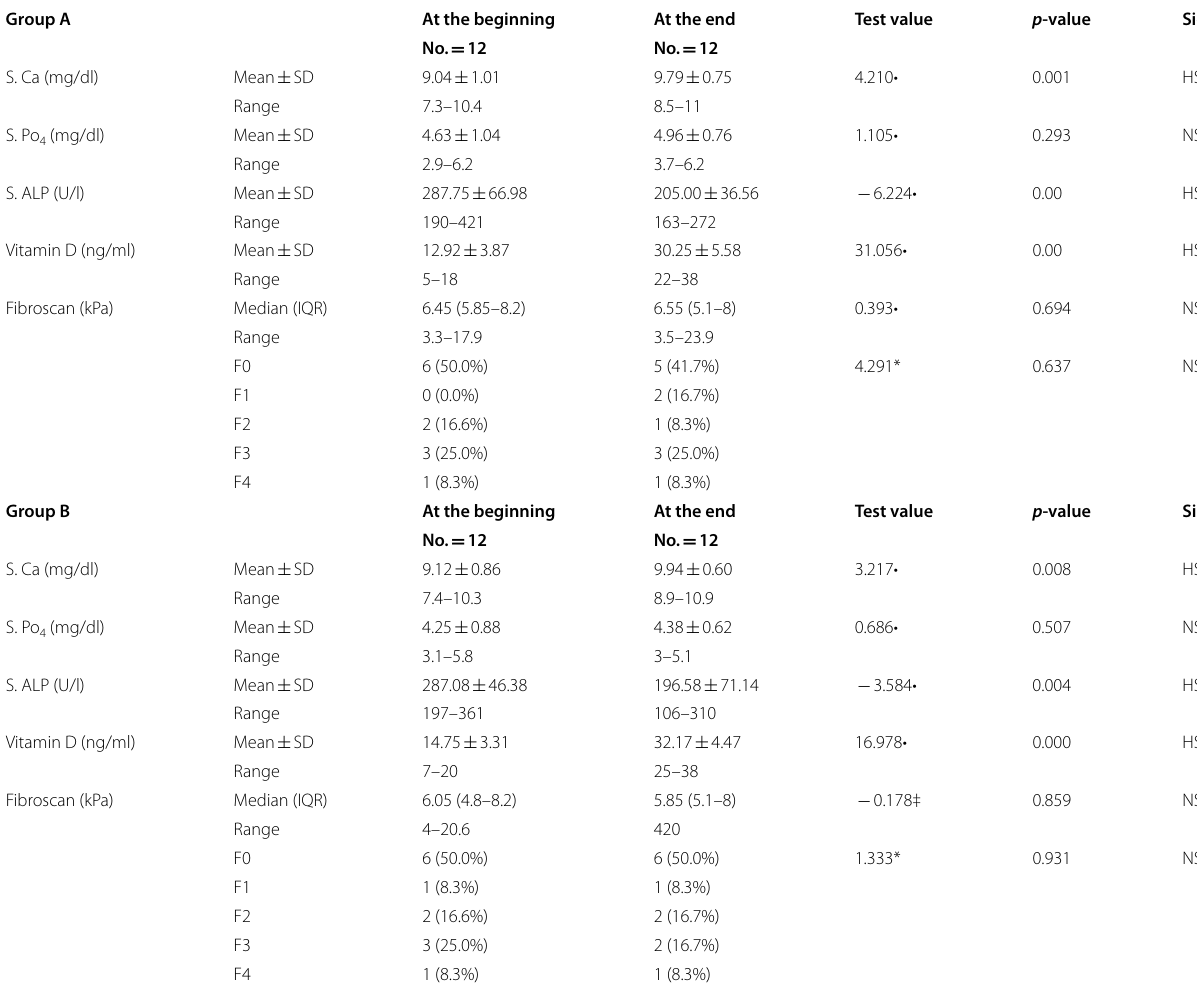
Table 7 Metabolic profile changes and fibroscan after vitamin D supplementation in both